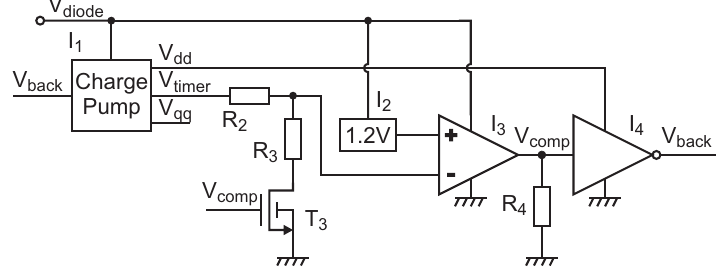
Figure 5. Schematic of the improved charge pump with a feedback loop.